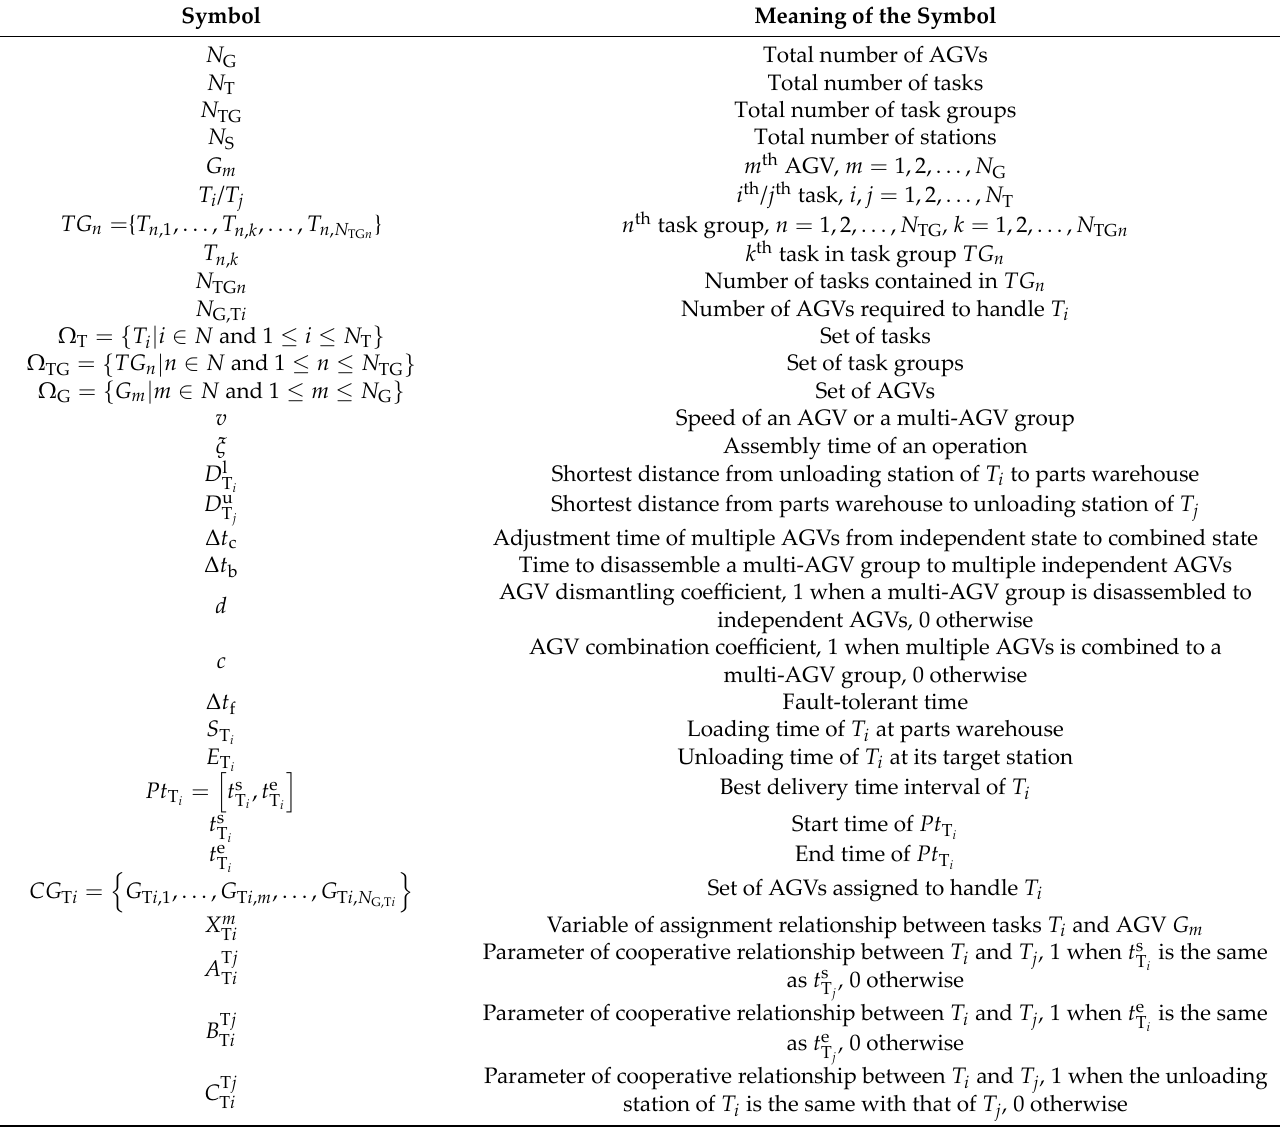
Table 1. The notations used in the